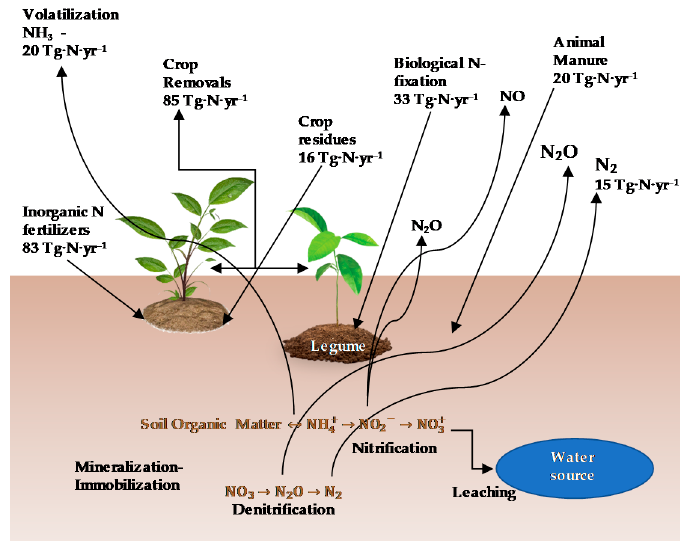
Figure 4. Simplified view of the nitrogen cycle in crop production. Estimated global N flows are quantified (inputs and losses, Tg·N·yr –1 ) [28,29].